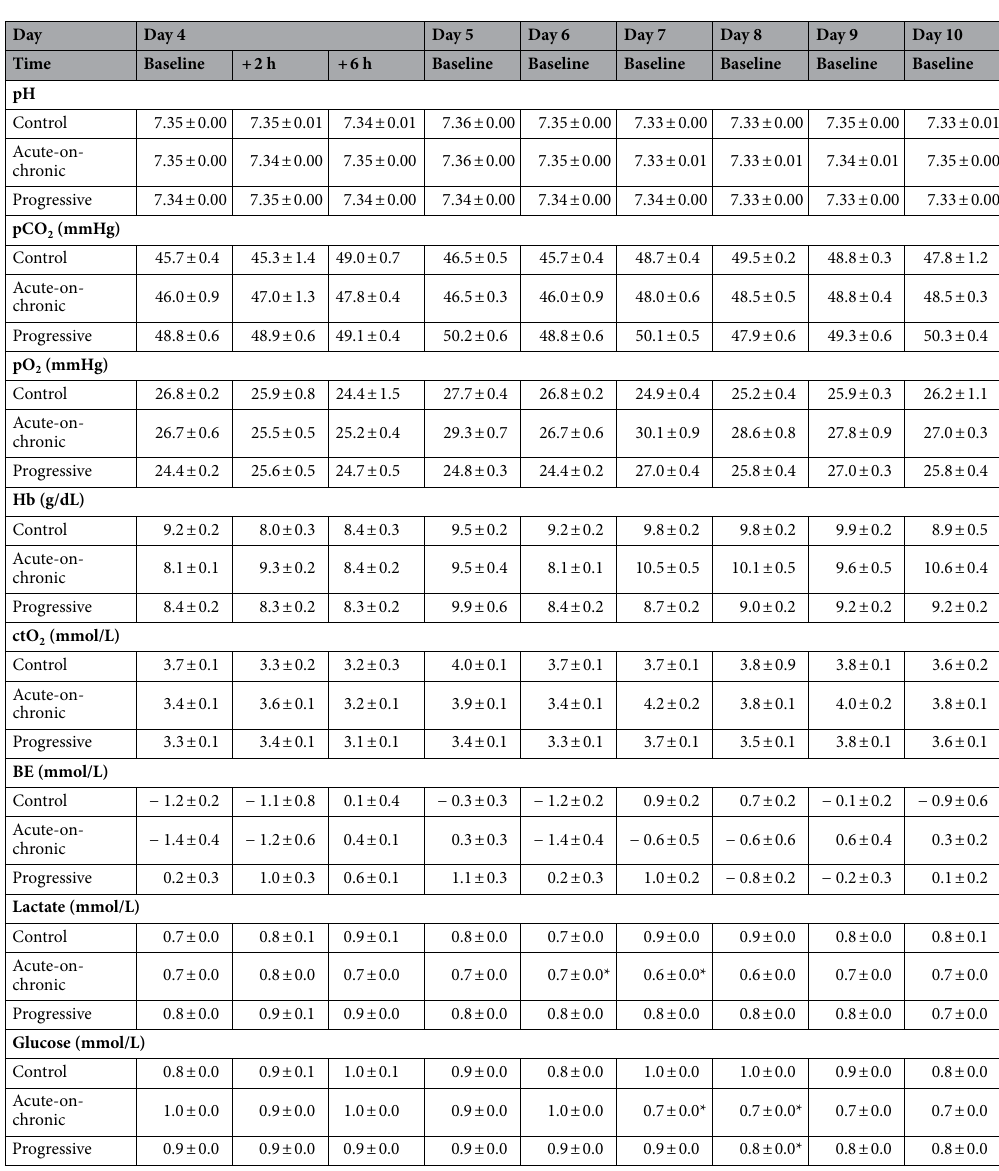
acceleration capacity (p = 0.037) and an increase in deceleration capacity (p = 0.033) was observed in the acute- on-chronic group compared to controls (Fig.